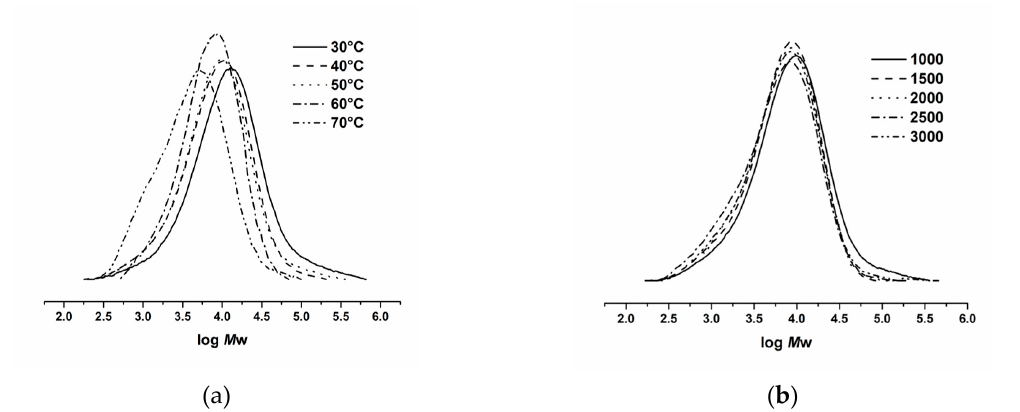
Figure 2. ( a ) GPC curves of polyethylene obtained by Co2/ MAO at various temperature (runs 1–5, Table 2); ( b ) GPC curves of polyethylene obtained using Co2/ MAO with different molar ratio of Al/Co (runs 3 and 6–11, Table 2).